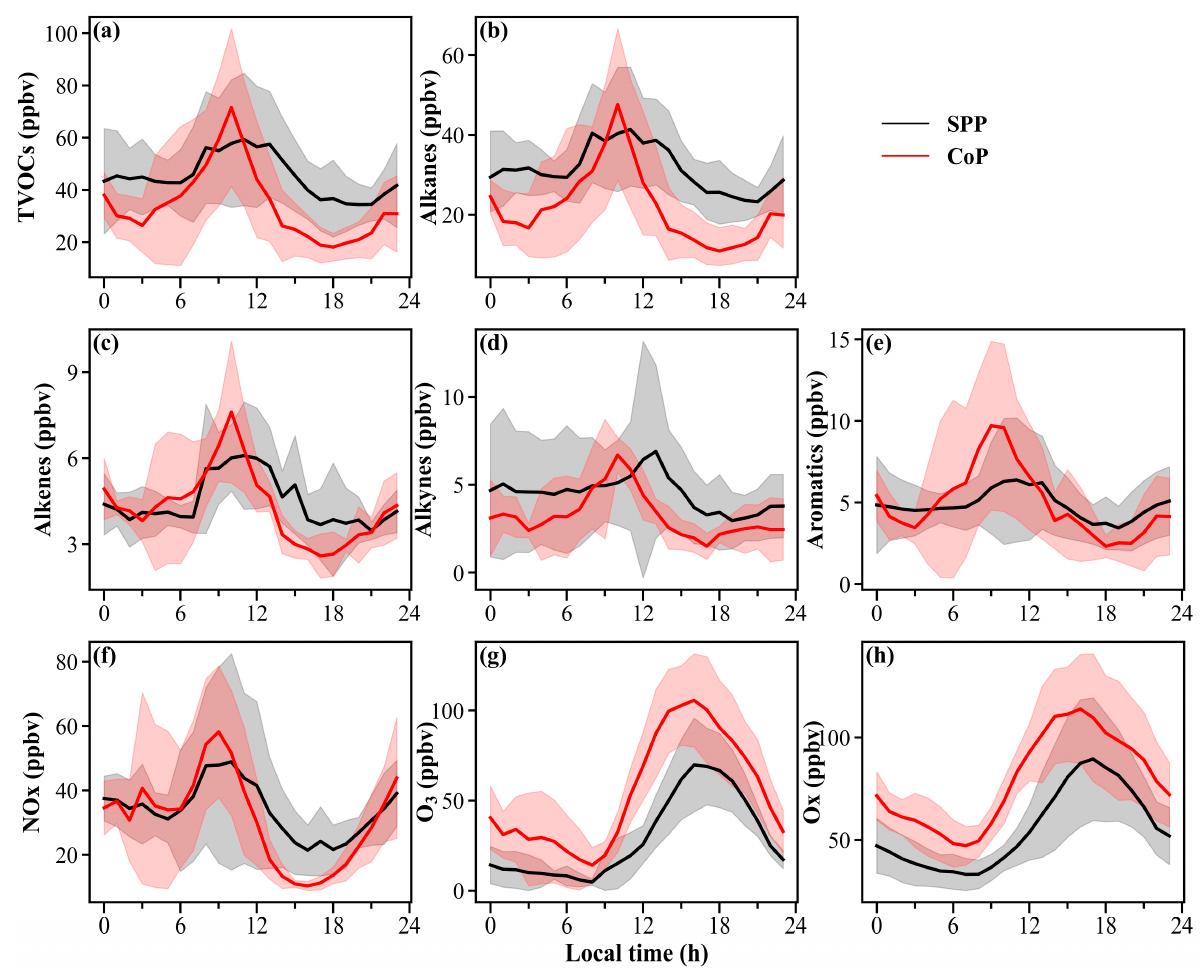
Figure 7. Diurnal patterns of VOCs ( a – e ), NOx ( f ), O 3 ( g ), and Ox ( h ) in different pollution episodes. The solid line and shaded areas are the mean and standard deviation, respectively.